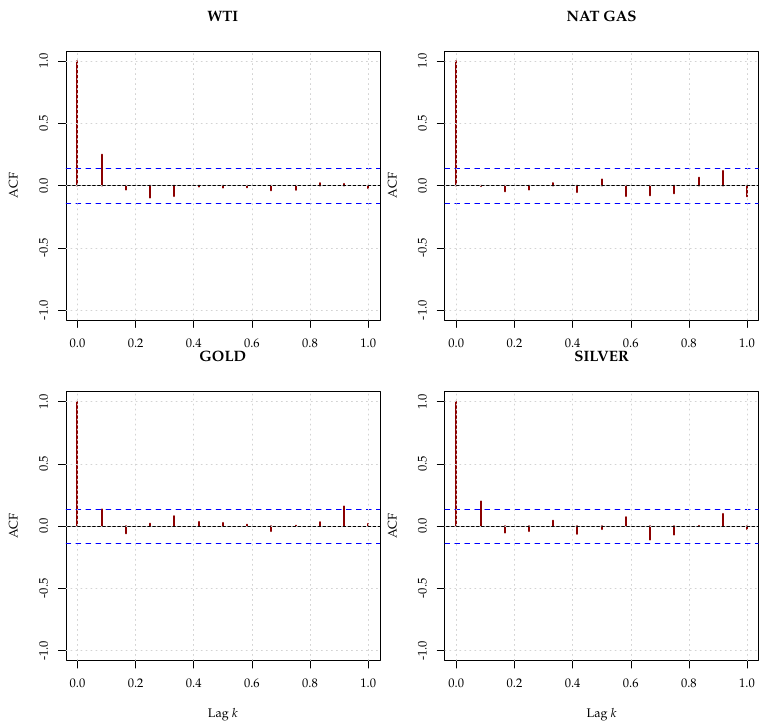
Figure 17. Sample correlograms for the four commodities up to one year. The confidence bands at level 99% under the white noise hypothesis are indicated as blue dashed horizontal